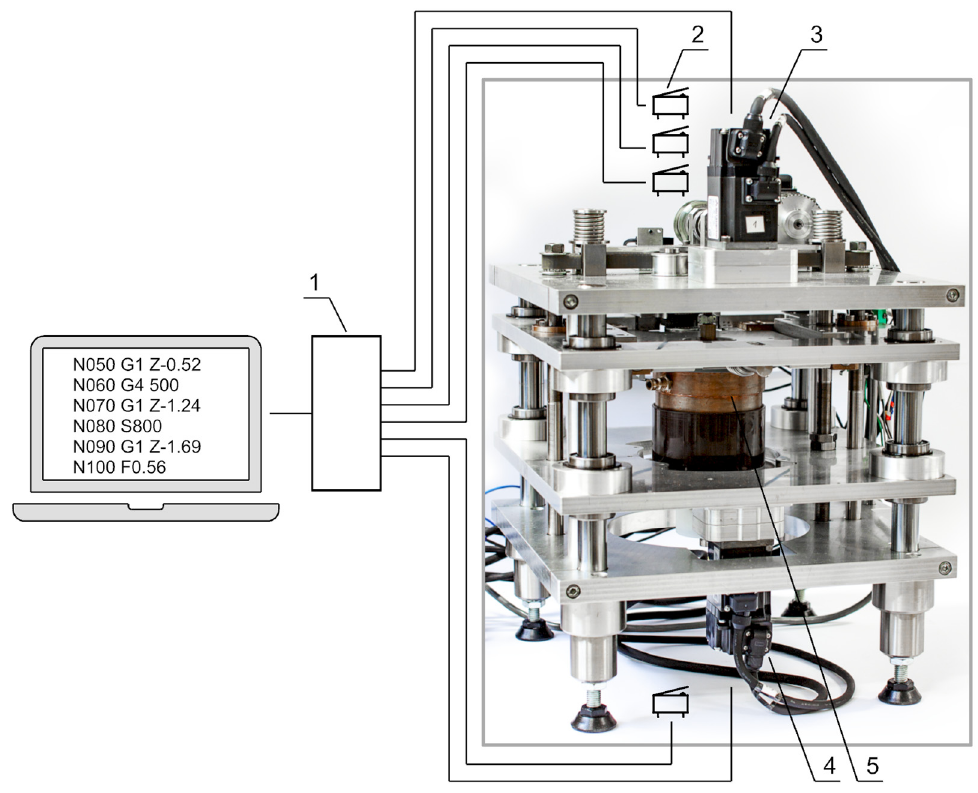
Figure 16. Elements of the control system: 1—Mitsubishi FX 3U driver with an FX 3U-232-BD I/O